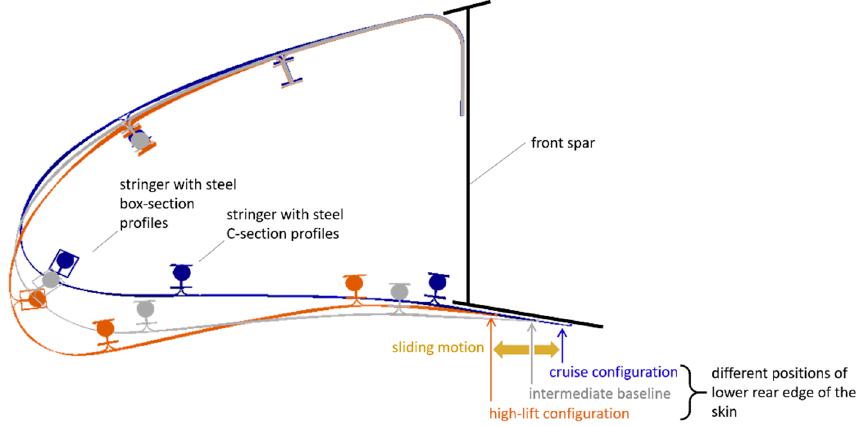
Figure 24. Schematic view of cruise-configuration (S4, blue), intermediate baseline shape (grey), and high-lift configuration (S5, orange) of the MLE; CFRP-stringers are each stiffened by a pair of steel profiles with box- or C-shaped cross-sections, respectively—the figure shows their cross-section including the fittings for the kinematic system (see Figure 11 for more detail); the rearward extension of the MLE’s skin slides along the lower surface of the front spar.